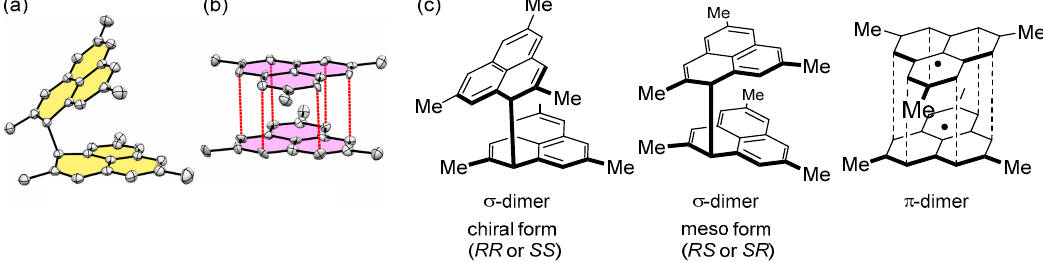
Figure 4. Various dimer forms of 6 . ORTEP (Oak Ridge Thermal-Ellipsoid Plot Program) drawing of ( a ) 6 2 - σ -chiral and ( b ) 6 2 - π . ( c ) Three structural isomers of the dimer of 6 .